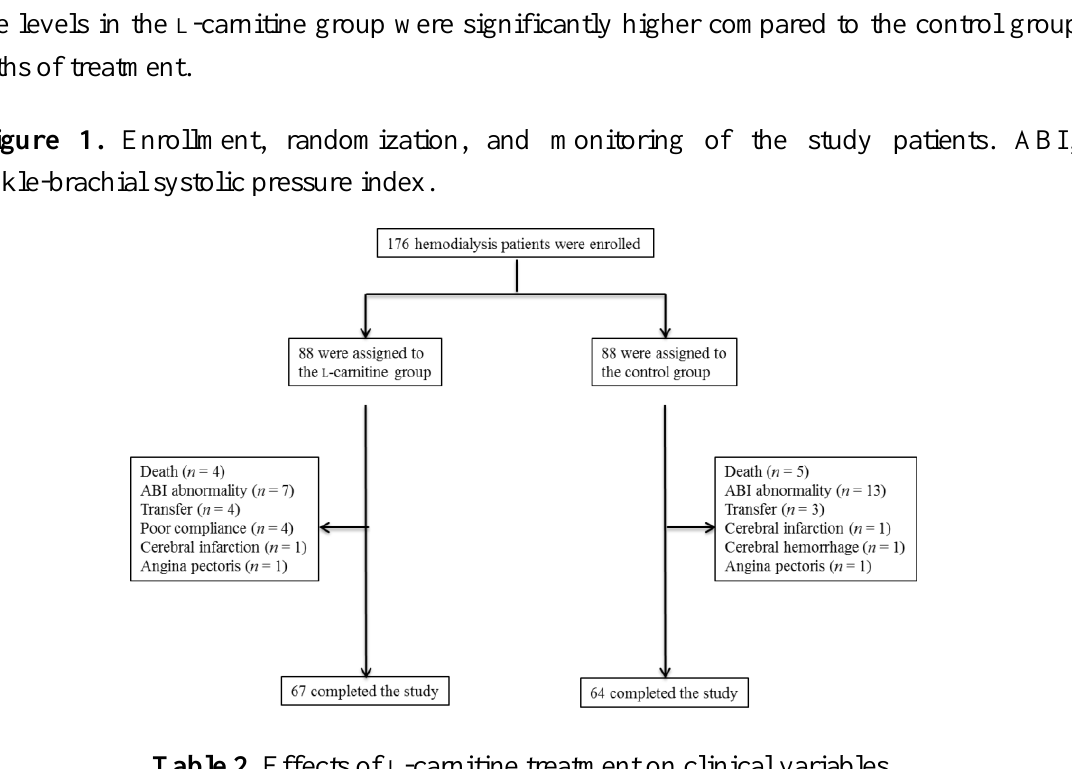
Table 2. Effects of L -carnitine treatment on clinical